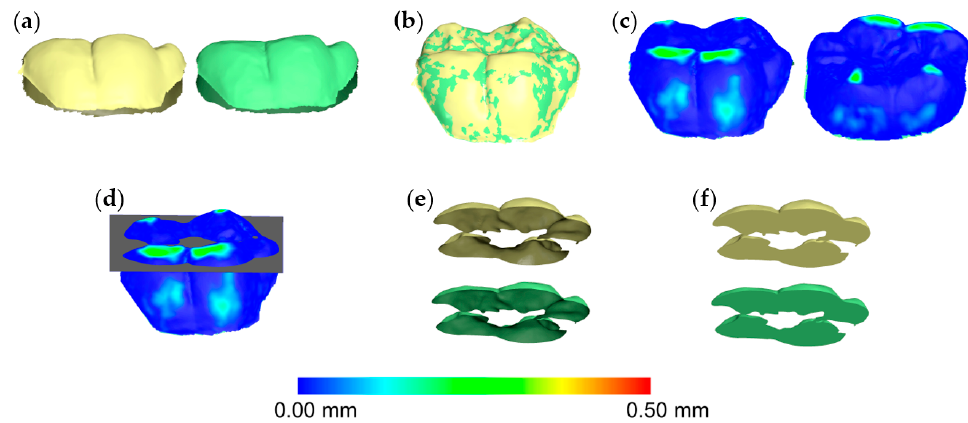
Figure 2. Workflow of tooth wear assessment in a mandibular first molar. ( a ) Tooth crown before (yellow) and after (green) wear simulation at the occlusal and the buccolingual surfaces. ( b ) Tooth crowns superimposed through the complete crown technique with setting D (30% estimated overlap). ( c ) Tooth wear from the buccal (left) and the lingual (right) aspect shown using a color coded distance map. ( d ) Simultaneous slicing of the two crowns using one level (grey). ( e ) Sliced tooth crown parts. ( f ) Watertight models created after the hole-filling process, used to calculate volumes.